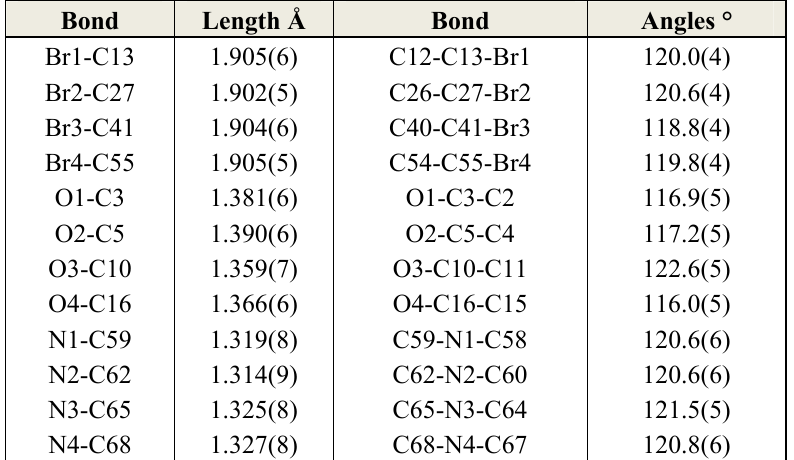
Table 1. Selected bond lengths and angles of C-5-bromo-2-hydroxyphenylcalix[4]-2- methylresorcinarene ( I ).